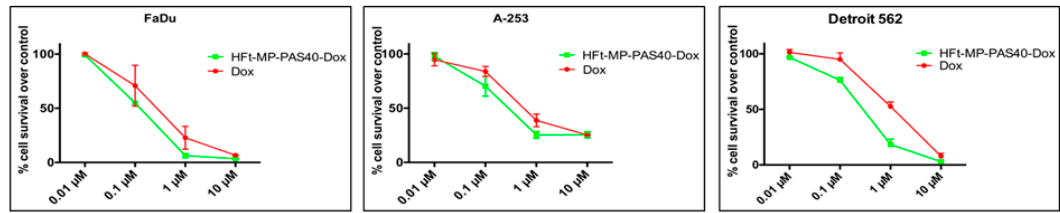
Figure 2. In vitro effects of HFt-MP-PAS40-Dox. Killing efficacy of Dox and HFt-MP-PAS40-Dox against human HNSCC cell lines. Cells were incubated for 72 h with different concentration of drugs. Cell viability was analyzed by CellTiter-Blue ® Cell Viability Assay. Mean ± SD ( n = 3), experiments were performed in triplicates.